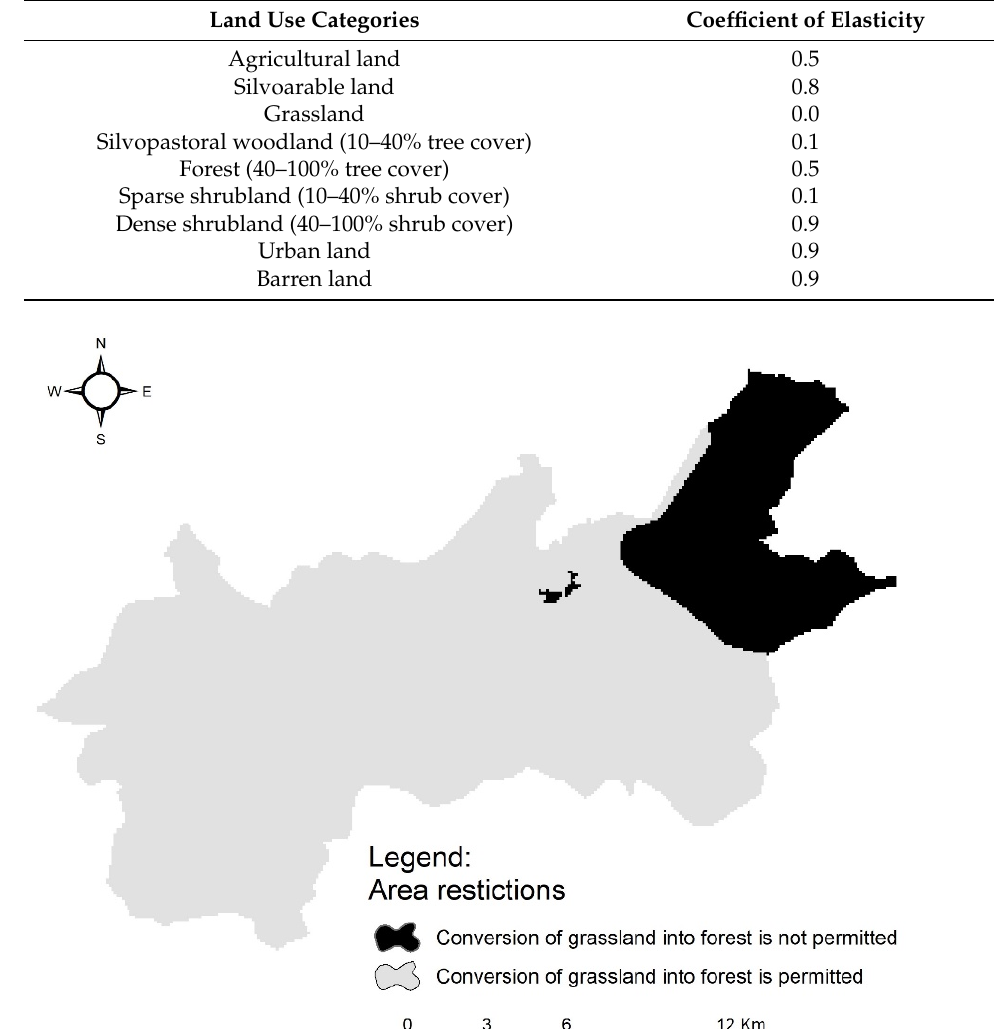
Table 2. Land use categories and the values of their coefficient elasticity. Land Use Categories